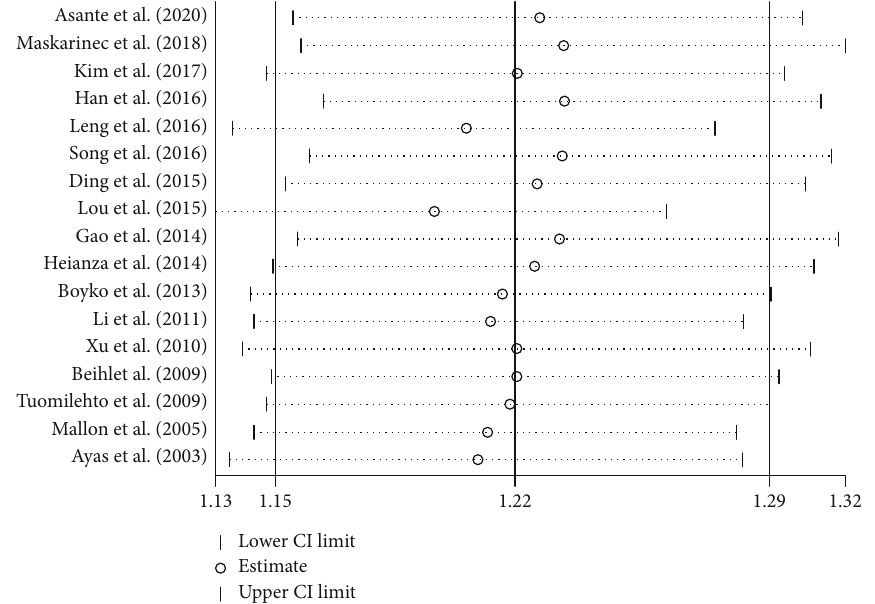
Figure 9: Sensitivity analyses of the association between SSD and